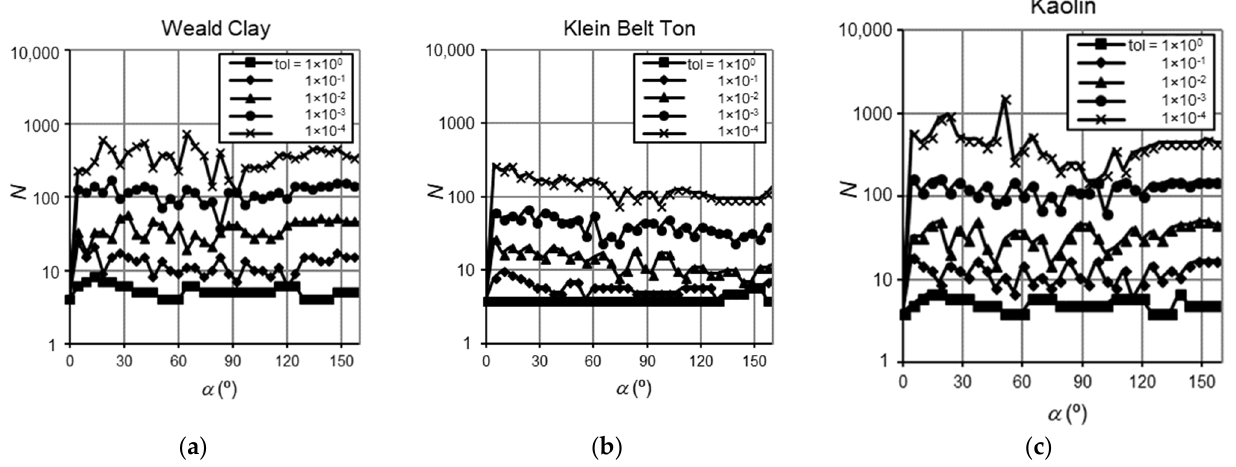
Figure 5. Minimum number N of subdivisions of the yield surface necessary to ensure a certain level of relative tolerance for each of the α strain paths defined in Figure 4 for ( a ) Weald clay, ( b ) Klein Belt Ton, and ( c ) kaolin.